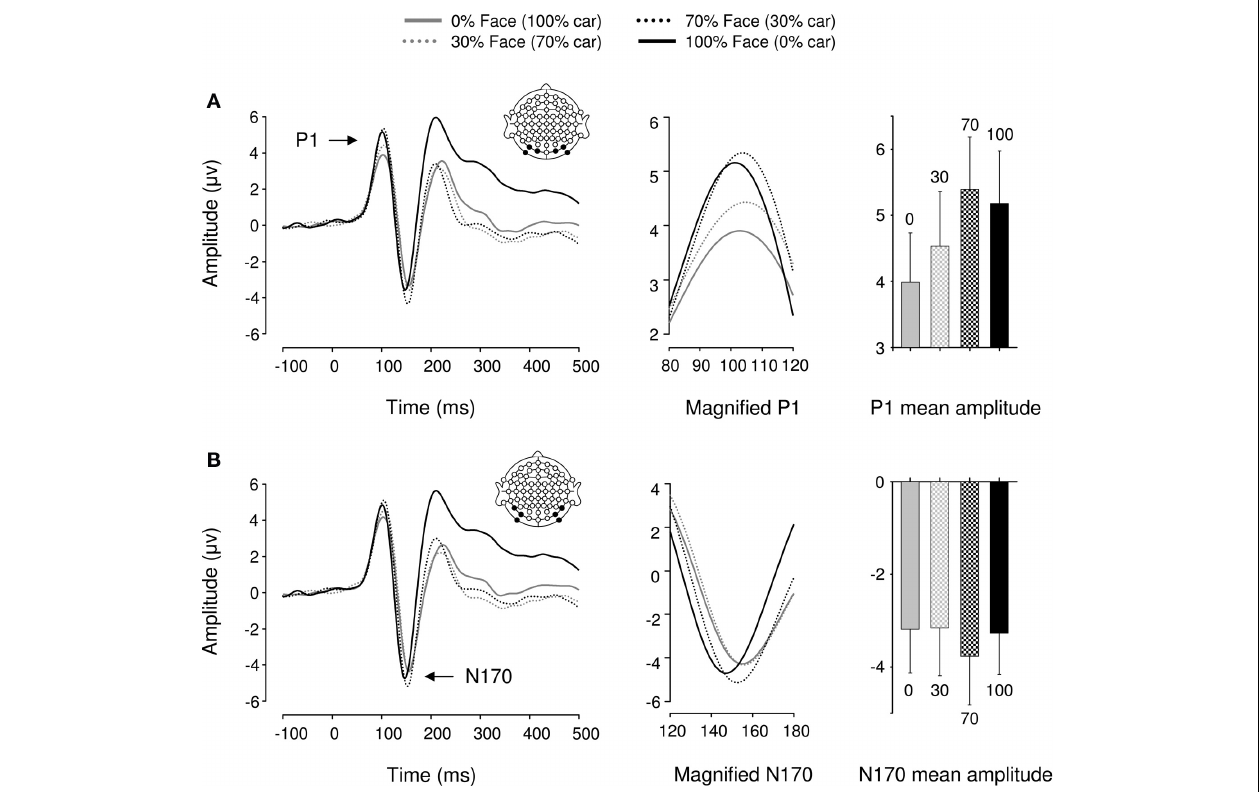
the P1, and bar plot of P1 mean amplitudes. (B) From left to right: linear derivation of electrodes P7, P8, PO7, PO8, PO9, and PO10, magnification of the N170, and bar plot of N170 mean amplitudes. Error bars depict